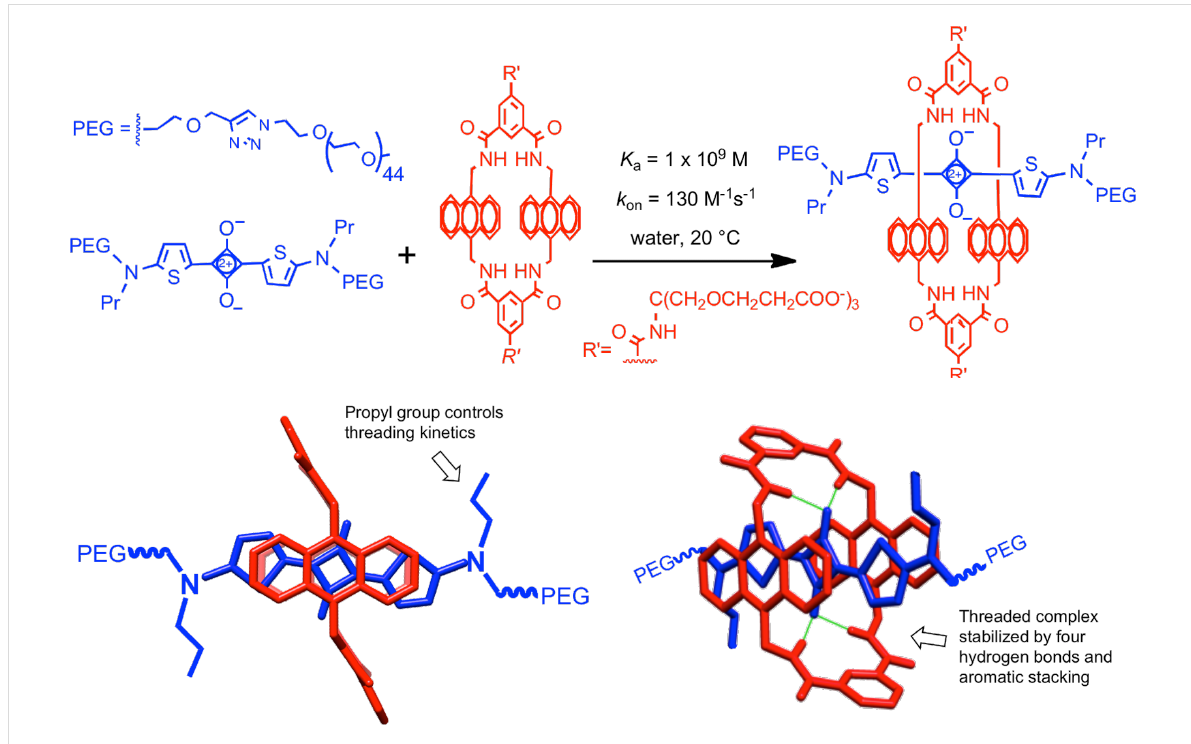
Scheme 5: (top) Basis of Synthavidin technology. A fluorescent squaraine dye that is flanked by PEG chains can rapidly thread a tetralactam macro- cycle in water to produce a highly stable complex. (bottom) Two views of the threaded complex highlighting the structural features controlling the threading kinetics and